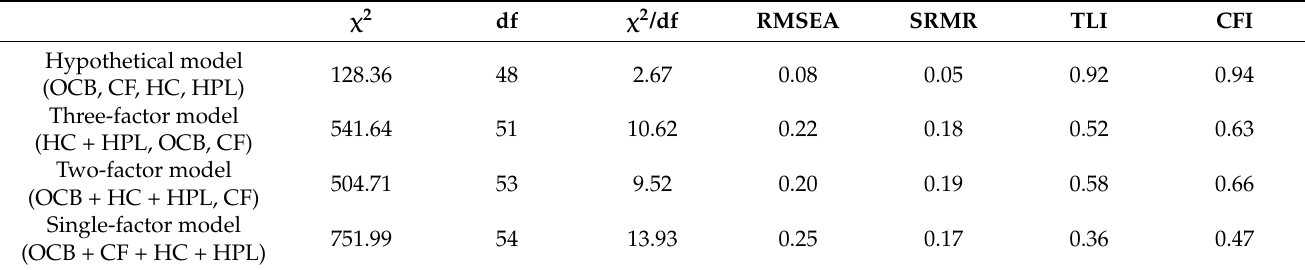
Table 1. Results of confirmatory factor